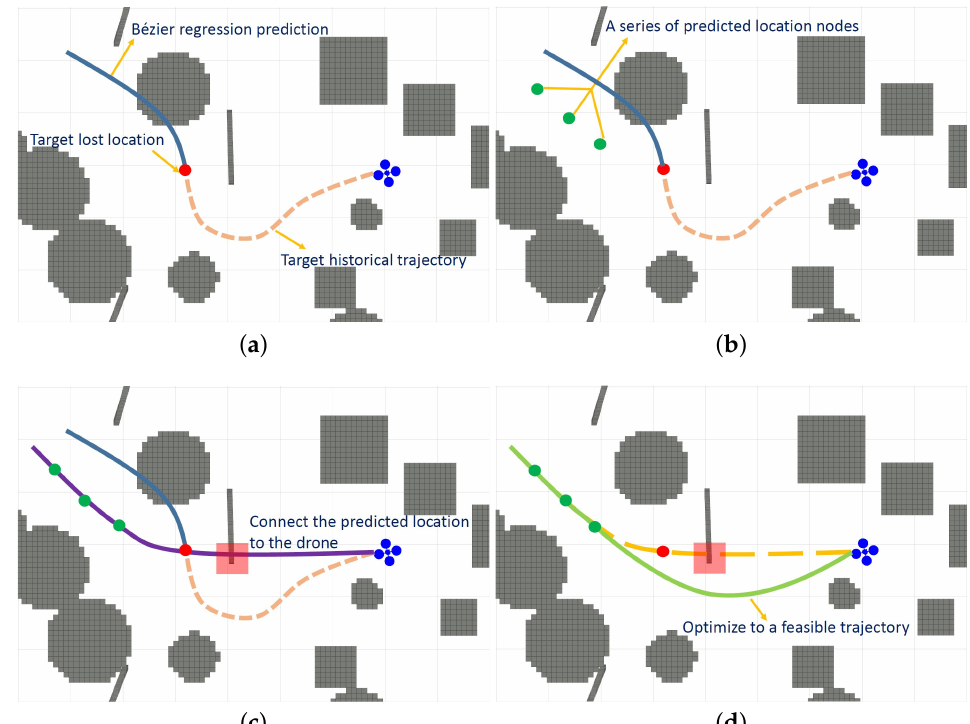
Figure 4. The expanded description of the relocation strategy. ( a ) The target motion prediction based on the Bézier regression interferes with the nearby obstacle. ( b ) The proposed target motion prediction considers the obstacles around the target lost point. ( c ) The predicted trajectory of the target and the current position of the UAV are connected to generate a flight corridor. ( d ) The backend optimizer regenerates a safe and dynamically feasible flight